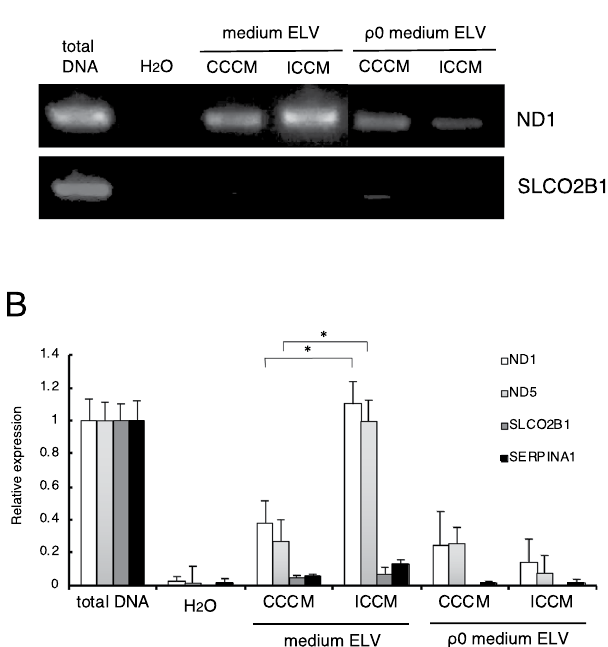
Figure 5. Mitochondrial DNA in ELV. ( A ) PCR amplification of mitochondrial ND1 (upper panel) and nuclear SLCO2B1 (lower panel) in CCCM ELV, ICCM ELV, ρ 0 CCCM ELV, and ρ 0 ICCM ELV. Full images of gels are present in Supplementary Fig. S3. ( B ) Quantification of mitochondrial DNA (mtDNA; ND1 and ND5) and nuclear DNA (nDNA; SLCO2B1 and SERPINA1) by RT-PCR in CCCM ELV, ICCM ELV, ρ 0 CCCM ELV, and ρ 0 ICCM ELV. Values are represented as mean ± standard error, with significant differences between indicated groups ( * ) calculated by Chi-square test ( p <